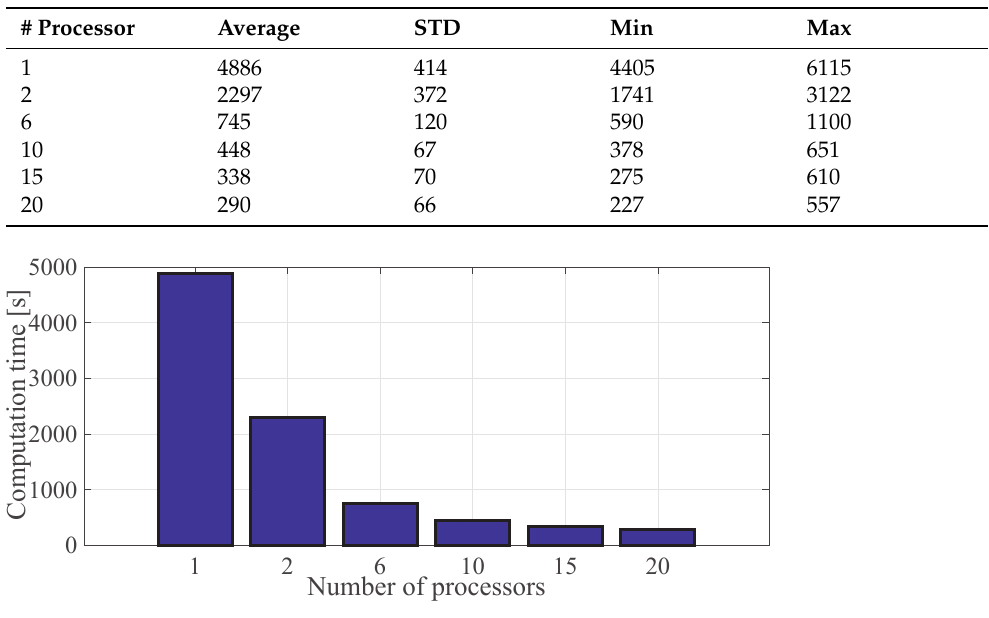
Figure 4. Average computational times of the